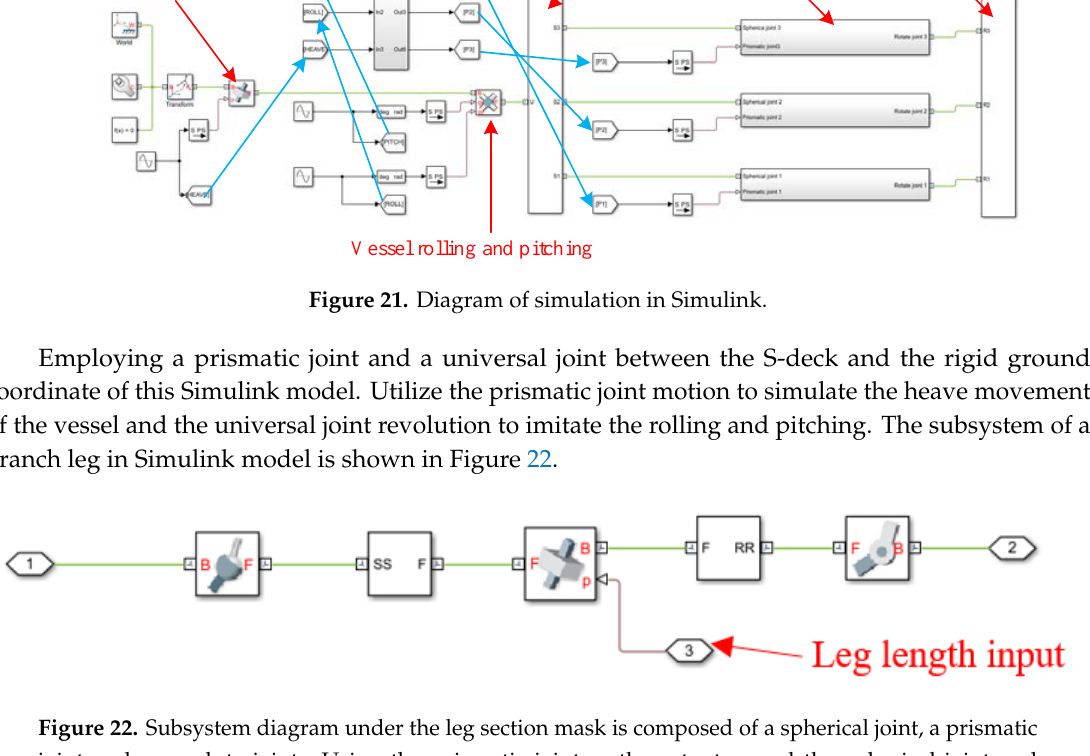
Figure 21. Diagram of simulation in Simulink.